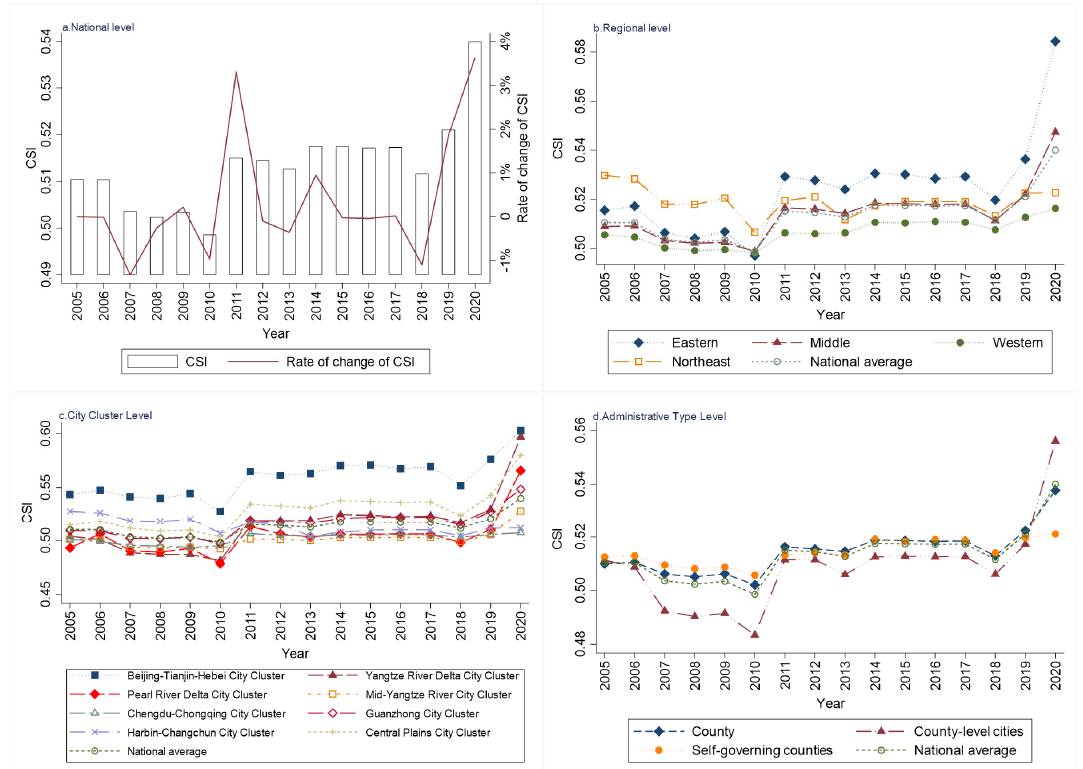
Figure 1. Time series trend of county sprawl.